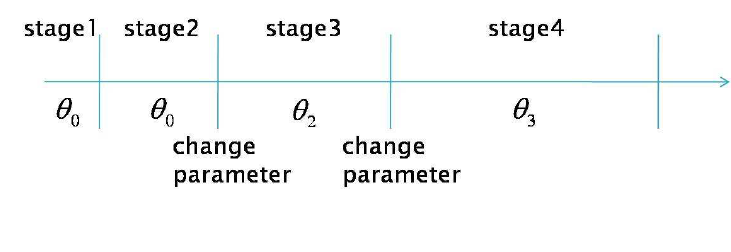
Figure 41. Illustration of multiple stages in successive